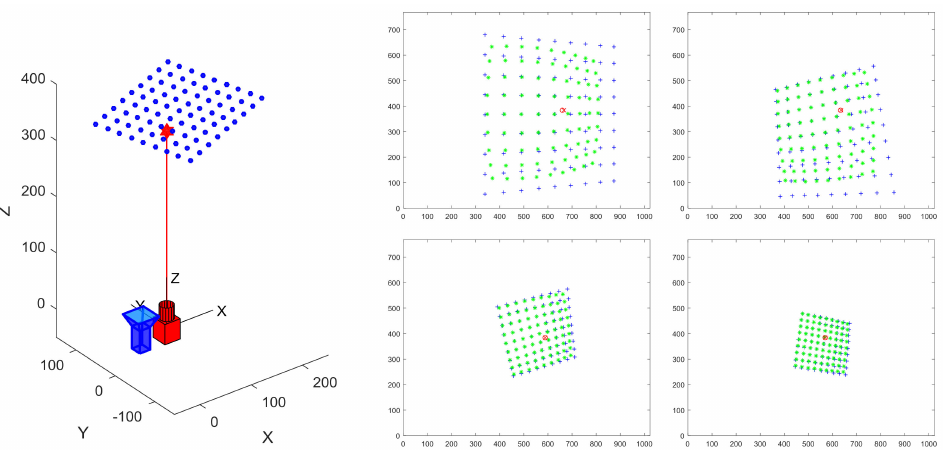
Figure 3. The imaging illustration. ( Left ) Schematic diagram of a simulated scenario. ( Right ) The generated image. The blue dots represent the ideal image points, the green dots represent the added distortion points, the red X represents the ideal image point of laser and the red circle is the distorted laser projection